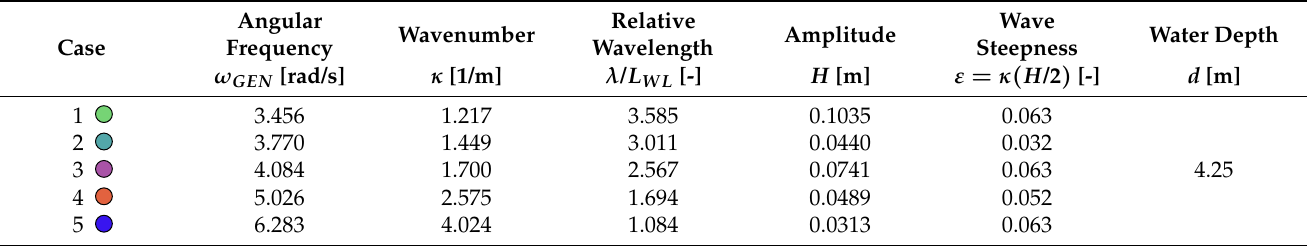
Table 2. Simulated wave conditions (deep water waves) as reproduced in the experimental facility; the colored dot represents the cases shown in the following charts.